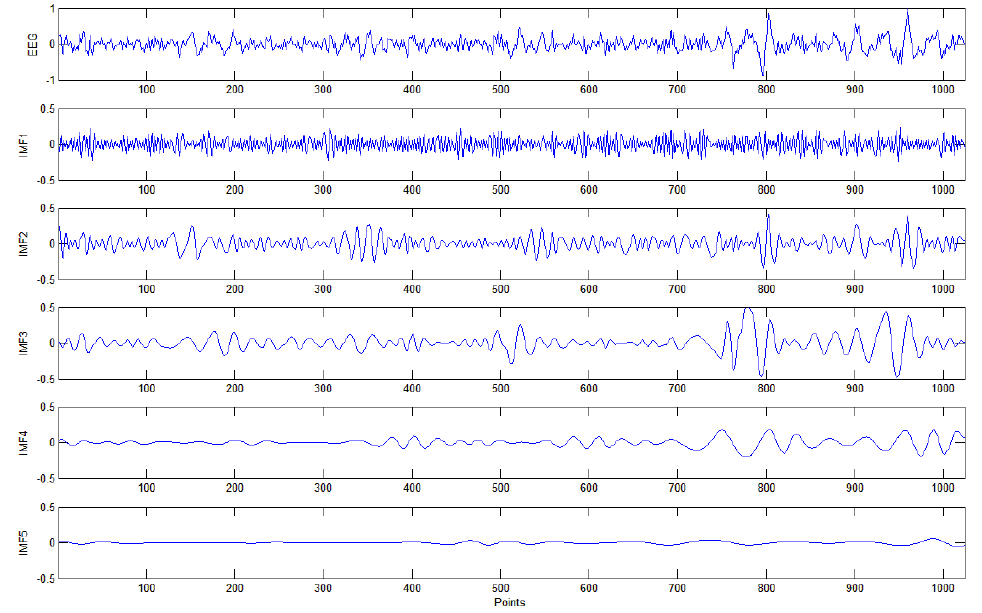
Figure 8. EEG signals and their corresponding first five IMFs.